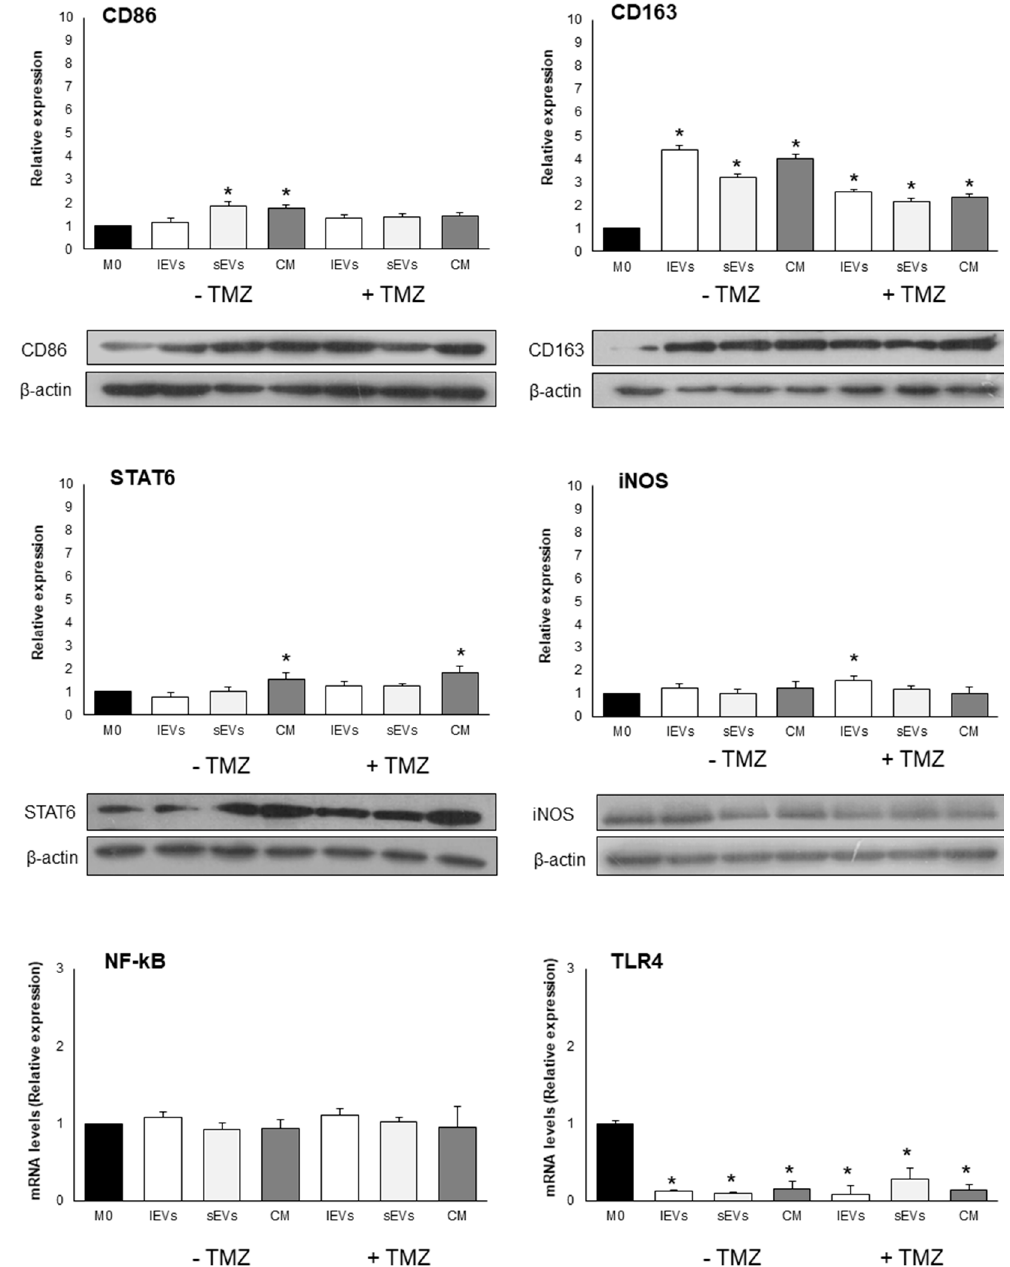
Figure 4. Macrophage polarization markers after exposure to 200 µM temozolomide (TMZ) for 48 h treated or non-TMZ- treated U-87 MG cells derived lEVs, sEVs and free EVs CM for 24 h. The expression of CD86, CD163, STAT6 and iNOS is normalized with the housekeeping protein ( β -actin) and reported as relative expression respect to control M0. The mRNA levels of TLR4 and NF-kB are normalized to GAPDH mRNA level and expressed as relative expression respect to M0. The values for all experimental groups reported in the histograms represent the means ± SD (n = 3) of three independent experiments; (*) p < 0.05 compared to control M0. Representative images of proteins blots are reported.